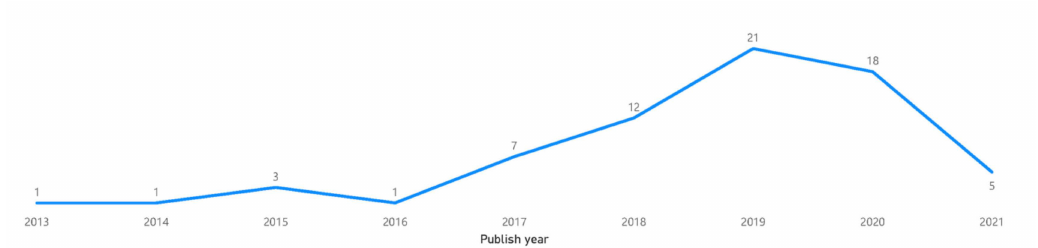
Figure 5. The records’ distribution in time.